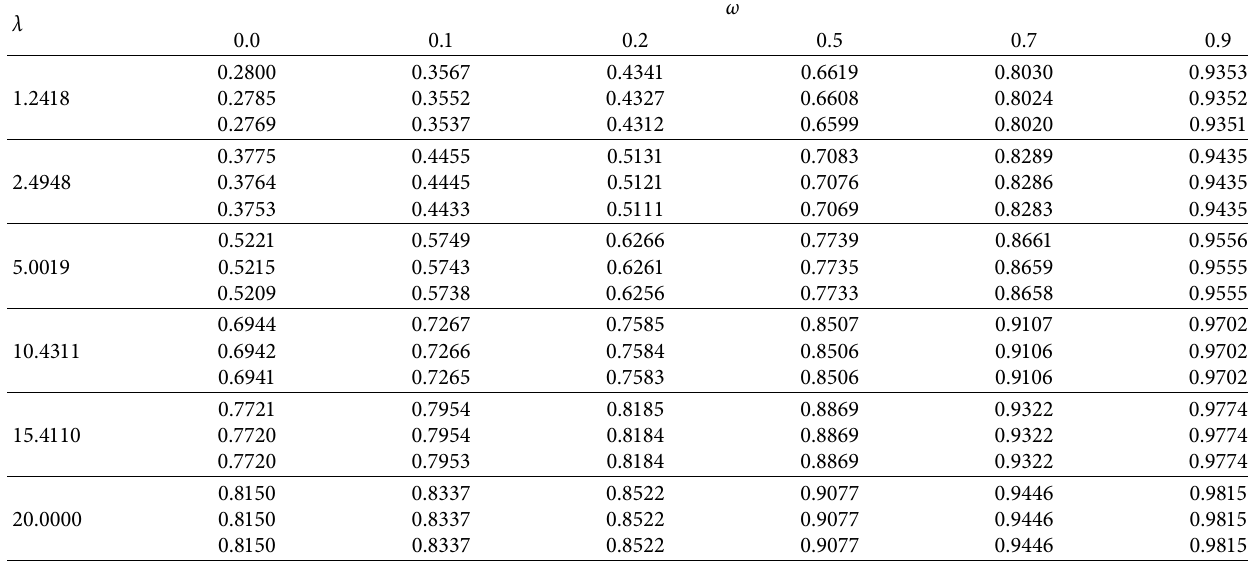
Table 1: Values of risk ratios R for d � 8 and diferent values of ω and λ � ‖ ] ‖ 2